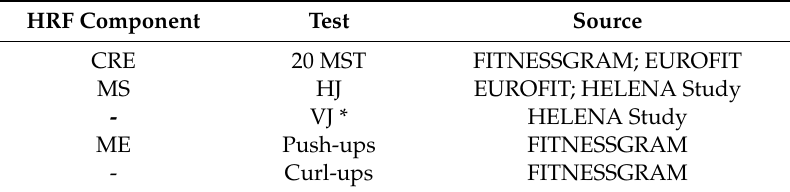
Table 1. Measurement of health-related fitness